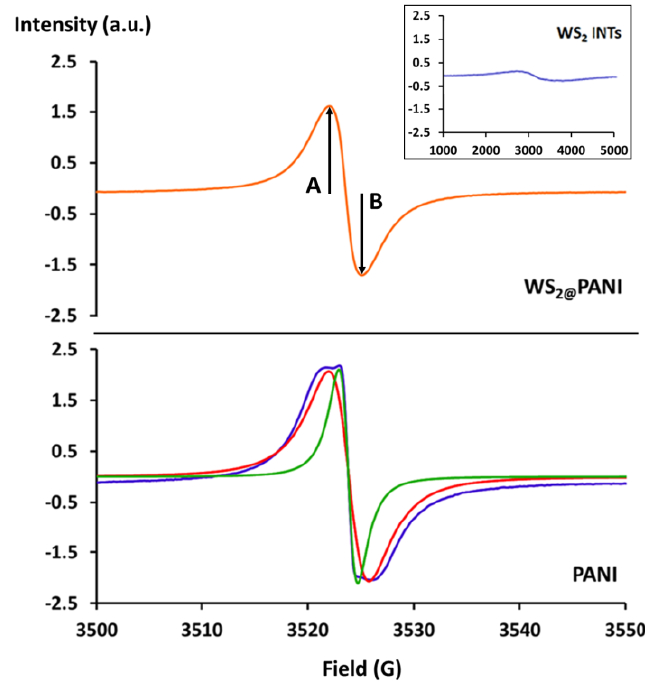
Figure 11. EPR spectra of WS 2 INTs, PANI and WS 2 @PANI composite. Symmetry parameter A/B is defined in WS 2 @PANI spectrum. Lorentzian peak fittings for PANI spectrum are plotted red and green. a